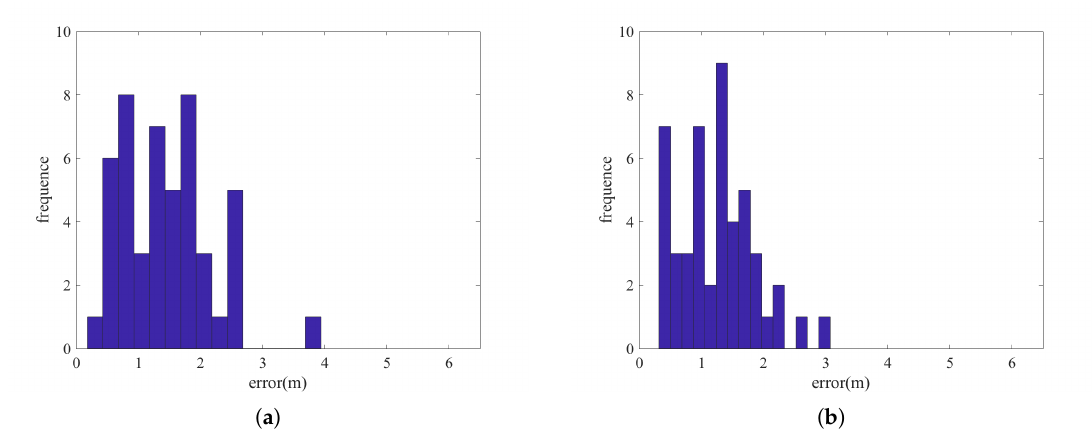
Figure 8. The histogram of beacon positions errors for dense beacons situation ( a ) Cost function with PDR constraint error terms and beacon position constraint error terms ( b ) Cost function with PDR constraint error terms, beacon position constraint error terms and fingerprint matching constraint error terms.